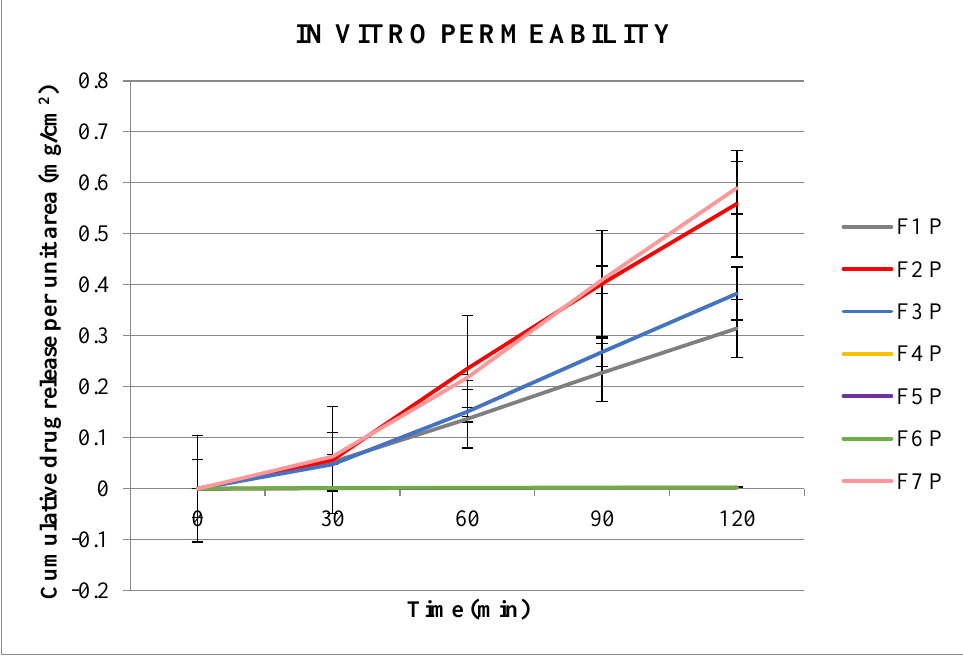
Figure 2. In vitro permeability of prilocaine for the various formulation of NIO− HAMIN emulgels. (P: prilocaine; L: lidocaine).